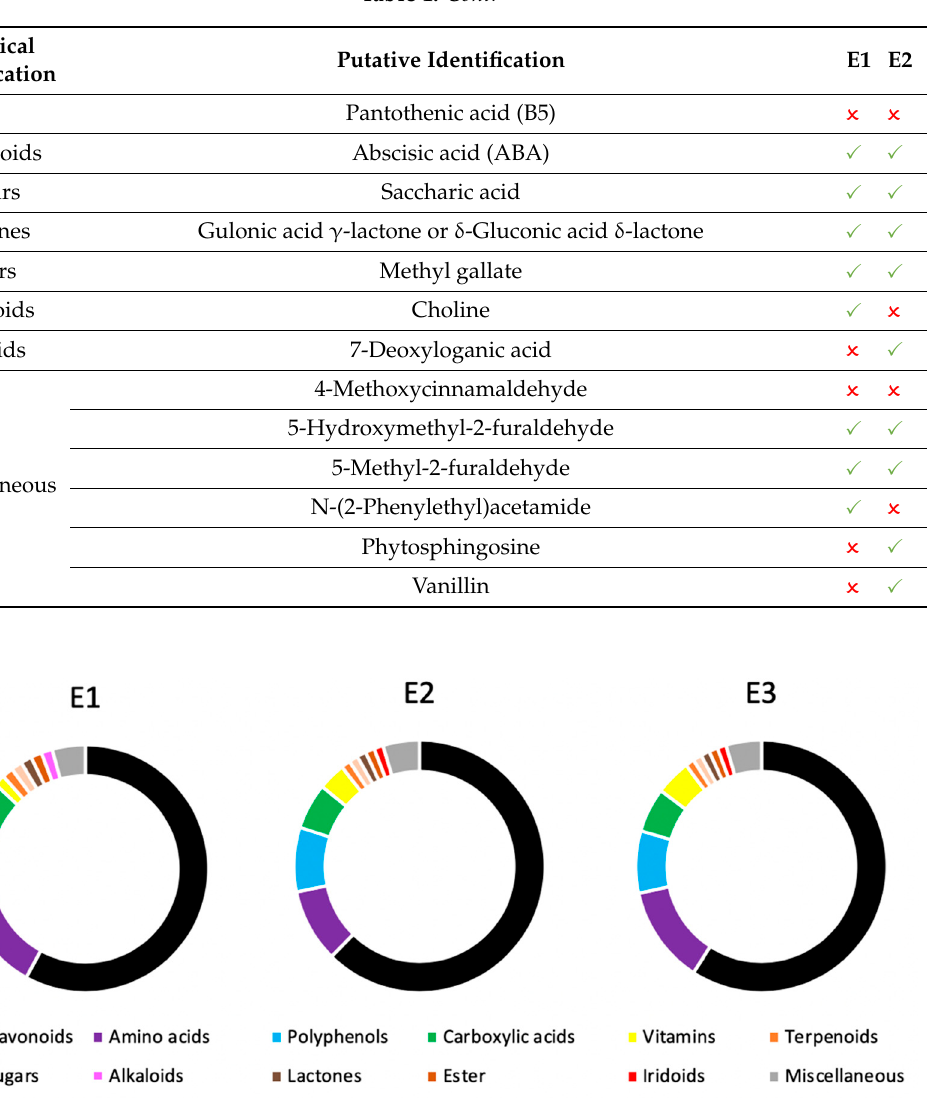
Table 2. Total polyphenolic and flavonoid content, along with antioxidant activity of the three formulations of the bilberry ripe fruit extracts. Extract Formulation